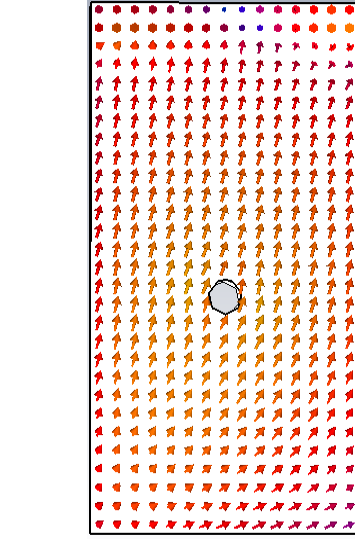
Figure 8. Effect of variation in the copper strip on the axial ratio.